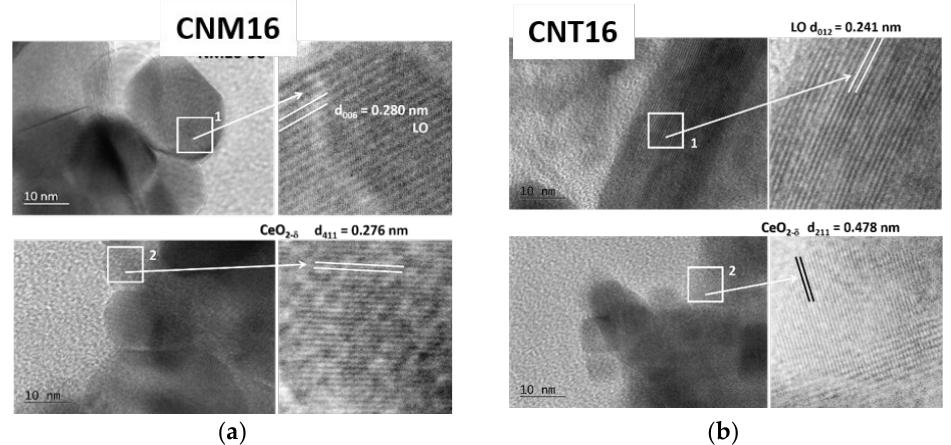
Figure 3. HR-TEM images of CNM16 ( a ) and CNT16 ( b ). The lattice fringes from the layered oxide (LO) and CeO 2 − δ are indicated.